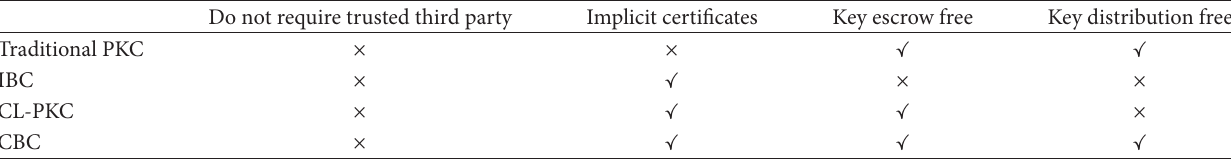
Table 1: Properties of the related public key